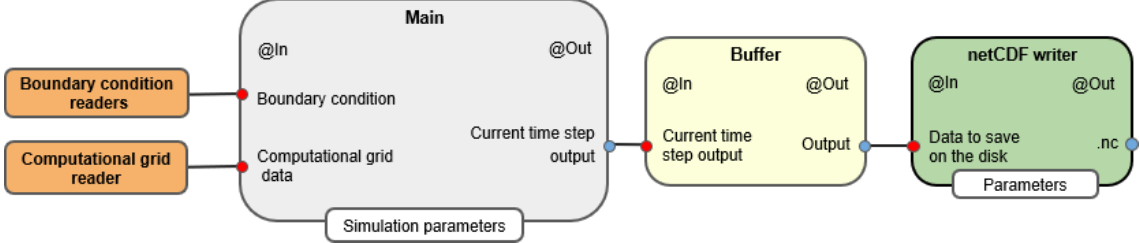
Figure 8. Workflow of WHETGEO-1D. The boundary condition readers, computational grid reader, Main , Buffer , and netCDF writer are stand-alone OMS3 components. Main stands for the generic component with the responsibility of solving the PDE; the Buffer temporarily stores output data that are later passed to the netCDF writer component, which in turn saves data to the disk. The Buffer component has the sole purpose of storing data. This has two advantages: the first one is to limit the number of accesses to the disk to save output, i.e. reducing the computational time, and the second one is to introduce a layer separating the Main component, which handles the numerical solution of the PDE, and the component responsible for saving